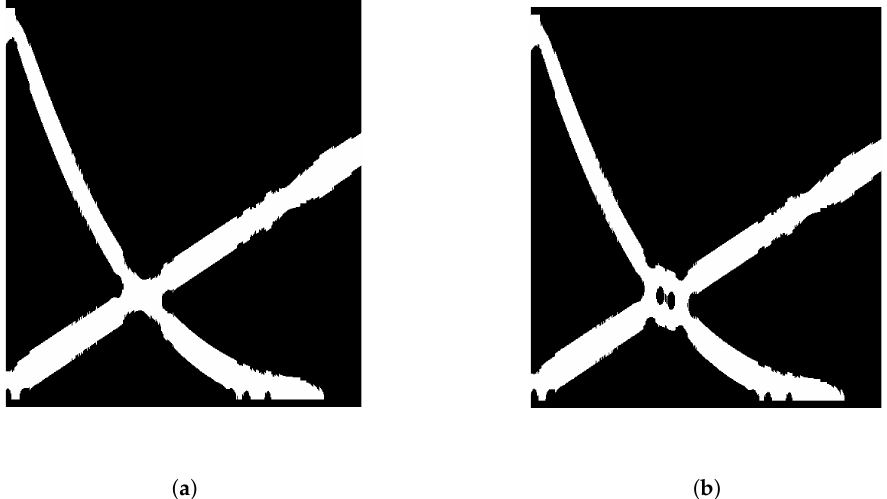
Figure 2. Binary maps. ( a ) of spectrogram shown in Figure 1a and ( b ) spectrogram in Figure 1b. Black holes appear in this latter